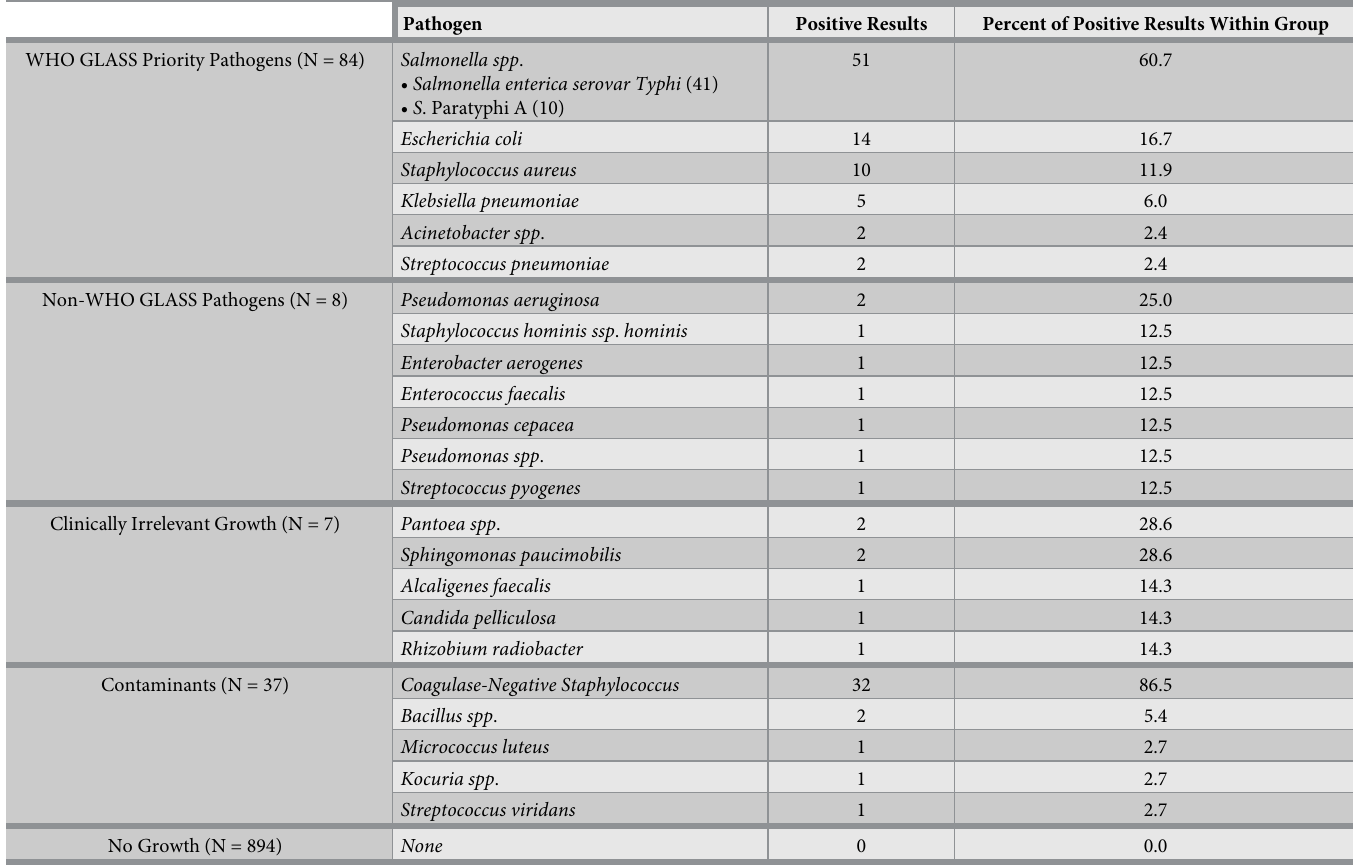
Table 1. Specific blood culture results among dengue-negative study